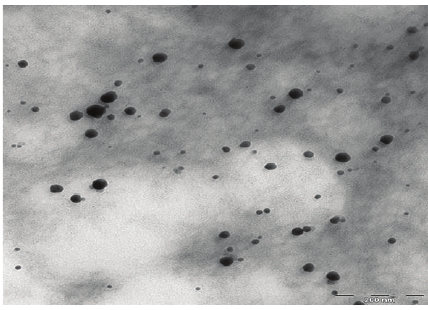
Figure 3: TEM image of AuNPs reduced with 200 mM of